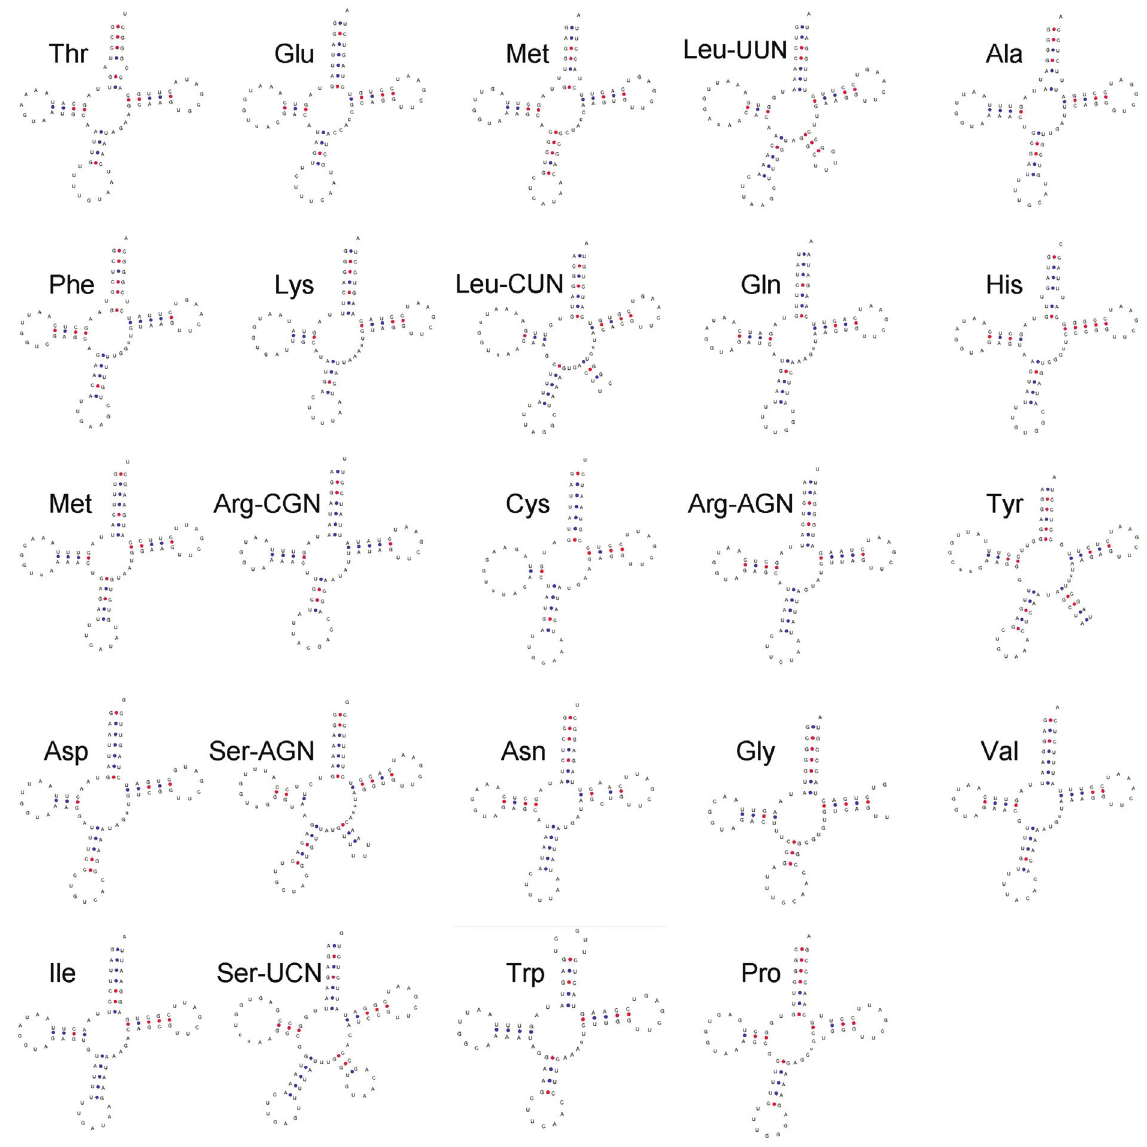
Figure 2 - Predicted tRNA structures of E. album